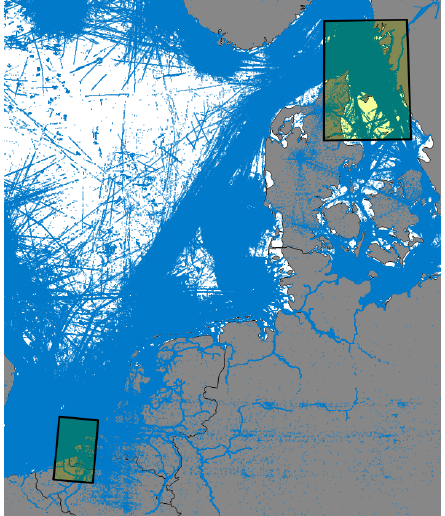
Figure 3. A visualization of the AIS position reports that we used as test data. The regions we used for queries are indicated by the yellow rectangles. Map projection: ETRS89 / LAEA